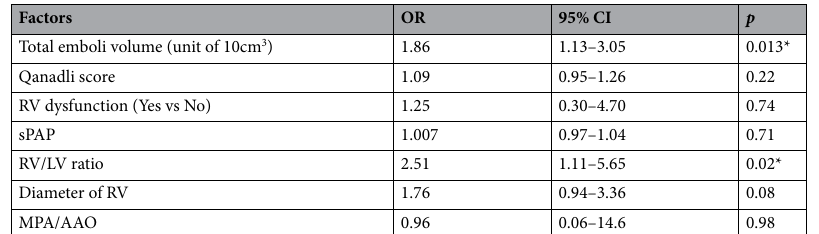
Table 5. Backward stepwise logistic regression for impending shock. The Full model includes total emboli volume, RV/LV ratio, MPA, MPA/AAO, chronic heart lung disease, age, gender, BNP, Troponin I, systolic blood pressure and respiratory rate as the factors. After backward stepwise selection, the remaining factors were total emboli volume, age, respiratory rate, and MPA. BNP B-type natriuretic peptide, RV right ventricle, LV left ventricle, MPA diameter of main pulmonary artery, AAO ascending aorta. * The threshold for statistical significance was p < 0.05.